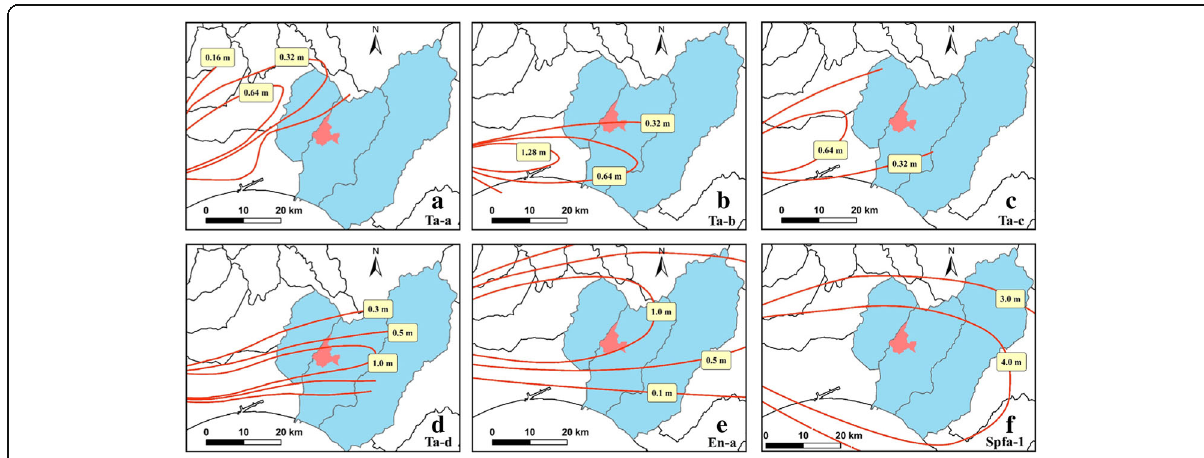
Fig. 5 Isopachs of pyroclastic fall deposits (Ta-a, Ta-b, Ta-c, Ta-d, En-a and Spfa-1) in the vicinity of the study area based on Machida and Arai (2003), Furukawa and Nakagawa (2010) and Hirose et al. (2018). a Isopachs of Ta-a layer. b Isopach of Ta-b layer. c Isopach of Ta-c layer. d Isopach of Ta-d layer. e Isopach of En-a laer. f Isopach of Spfa-1